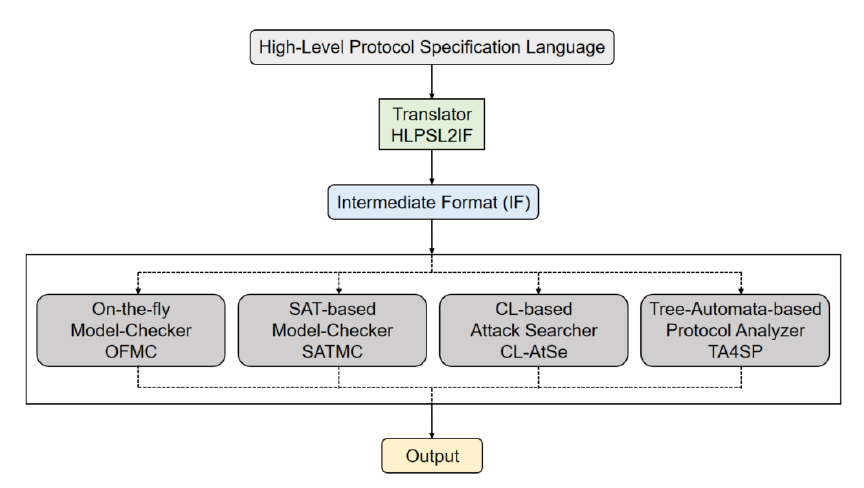
Figure 7. Architecture of Automated Validation of Internet Security Protocols and Applications